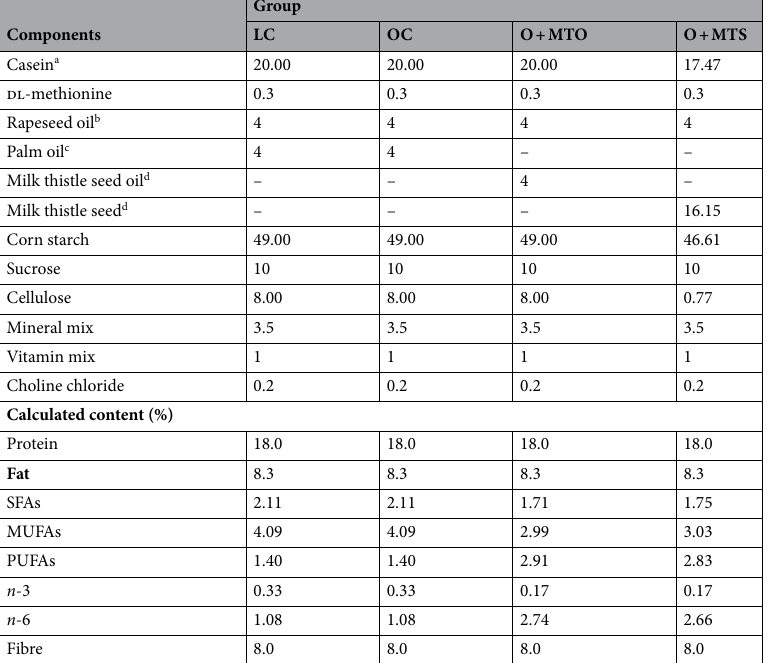
Table 2. Composition of the diets fed to rats (g/100 g diet). MUFA monounsaturated fatty acid, PUFA polyunsaturated fatty acid, SFA saturated fatty acid, LC lean control, OC obese control, O + MTO obese fed a diet containing milk thistle oil, O + MTS obese fed a diet containing milk thistle seeds. a Casein preparation (g/100 g): crude protein, 88.70; crude fat, 0.3; ash, 2.0; water, 8.0. b Canola type oil with the following fatty acid profile (%): SFAs, 6.49; MUFAs, 62.9 including oleic acid, 56.9; PUFAs, 25.9 including linoleic acid and α -linolenic acid, 17.5 and 8.06, respectively. c Fatty acid profile (%): SFAs, 46.3 including palmitic acid, 40.8; MUFAs, 39.4 including oleic acid, 39.1; PUFAs, 9.21 including linoleic acid, 9.1. d Chemical composition